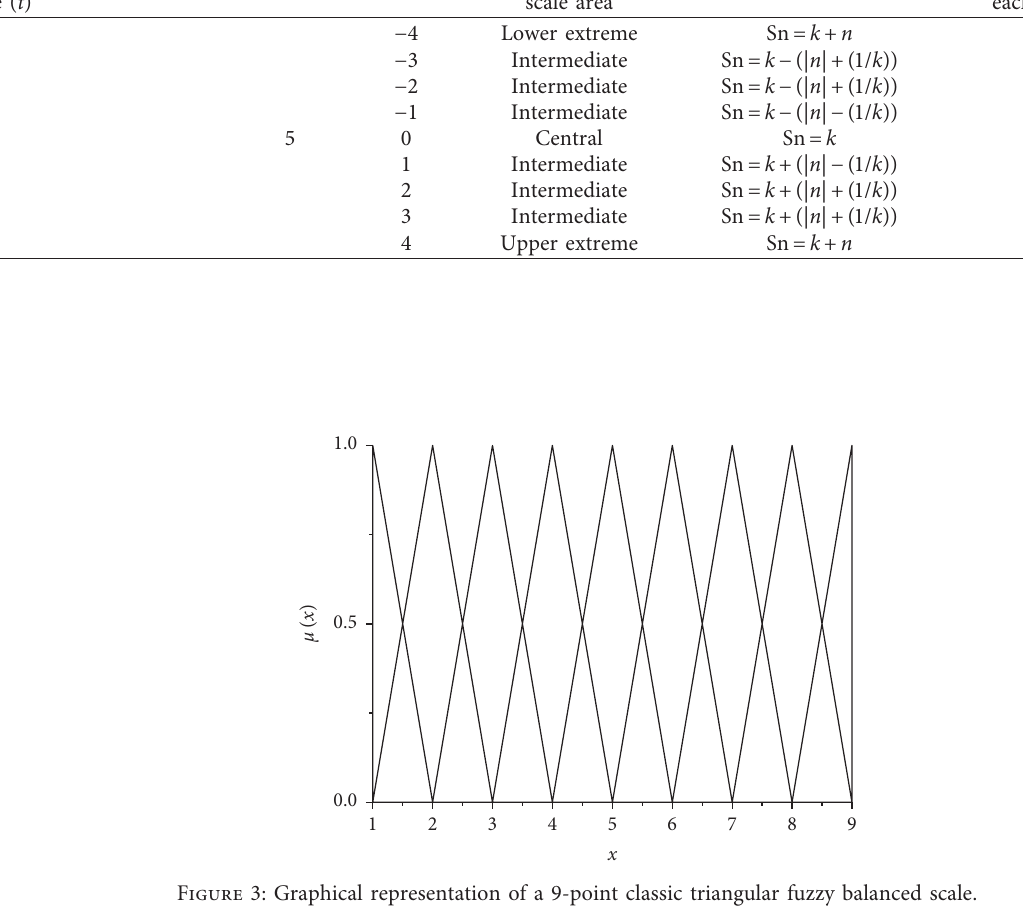
Table 1: Central values for each category in the 9-point fuzzy nonbalanced scale. Categories depending on the Number of points in the K � ( t +1)/2 n scale scale ( t )